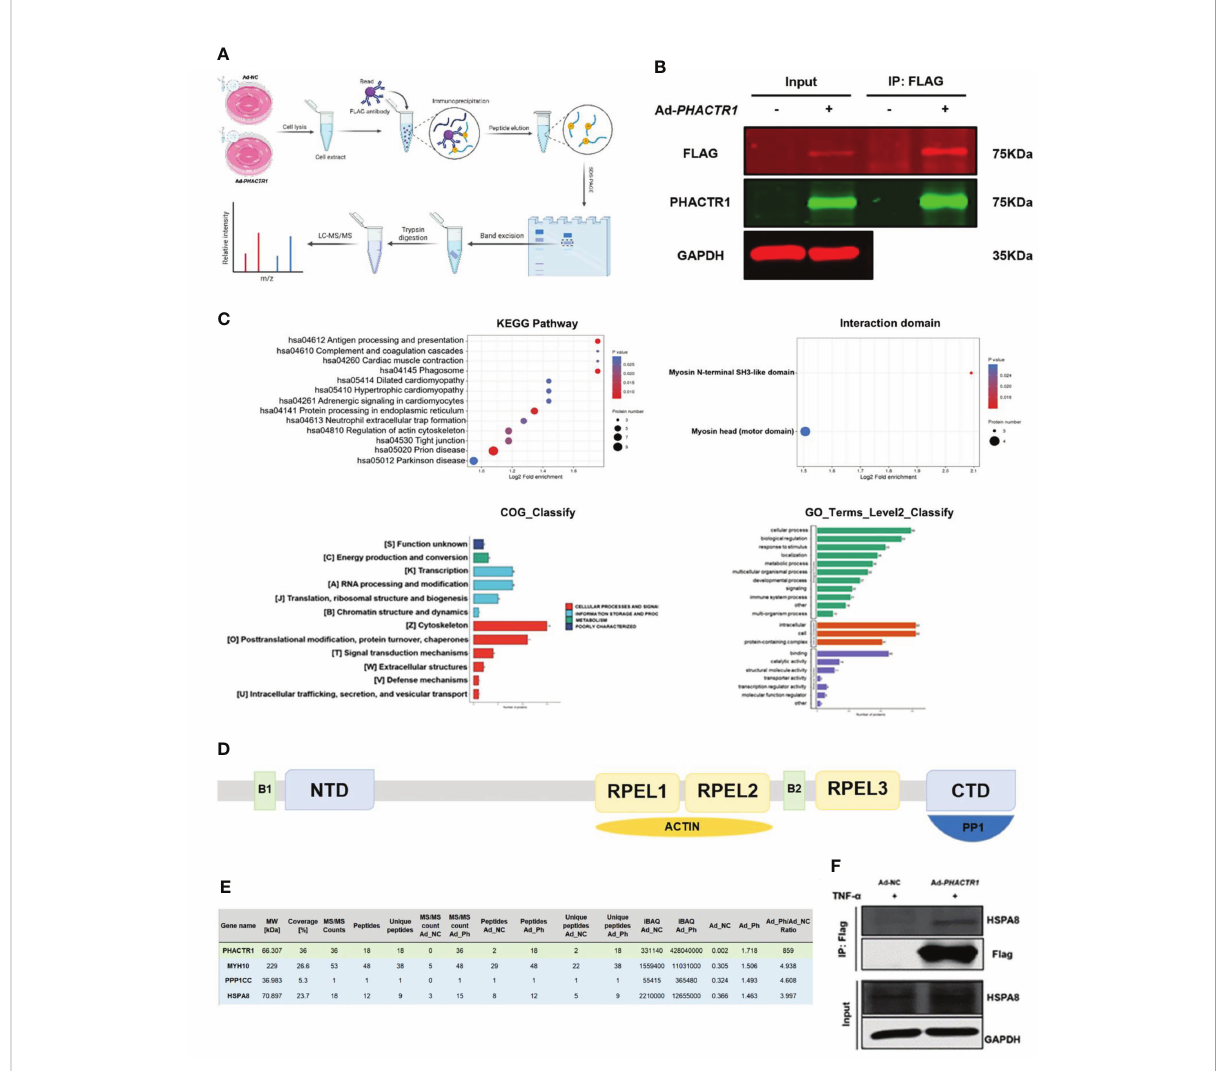
FIGURE 6 PHACTR1 interactomics in TNF- a -induced HUVECs. (A) Scheme of Co-IP study design created with Biorender.com. (B) Successful IP of PHACTR1 in TNF- a -treated (10 ng/mL, 6 h) HUVECs revealed by Li-Cor Infrared Imaging. (C) GO and KEGG analysis of PHACTR1 interactomics. (D) Schematic diagram of PHACTR family protein sequence elements. (E) PHACTR1 potential interacting protein were selected by Co-IP. (F) Co- IP of PHACTR1 and HSPA8 in HUVECs treated with TNF- a (10 ng/mL, 6